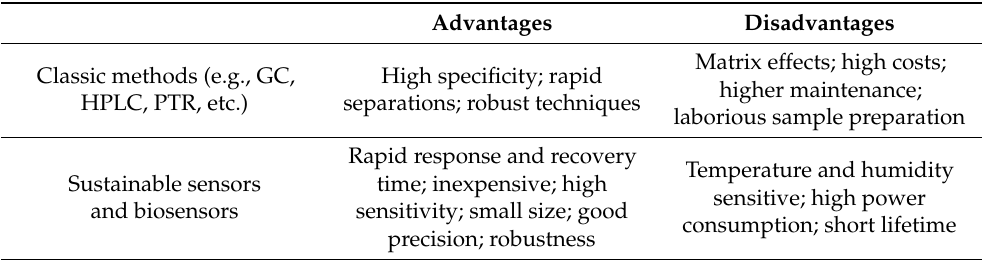
Table 3. Advantages and disadvantages of classic tools and sustainable sensors and biosensors for the detection of